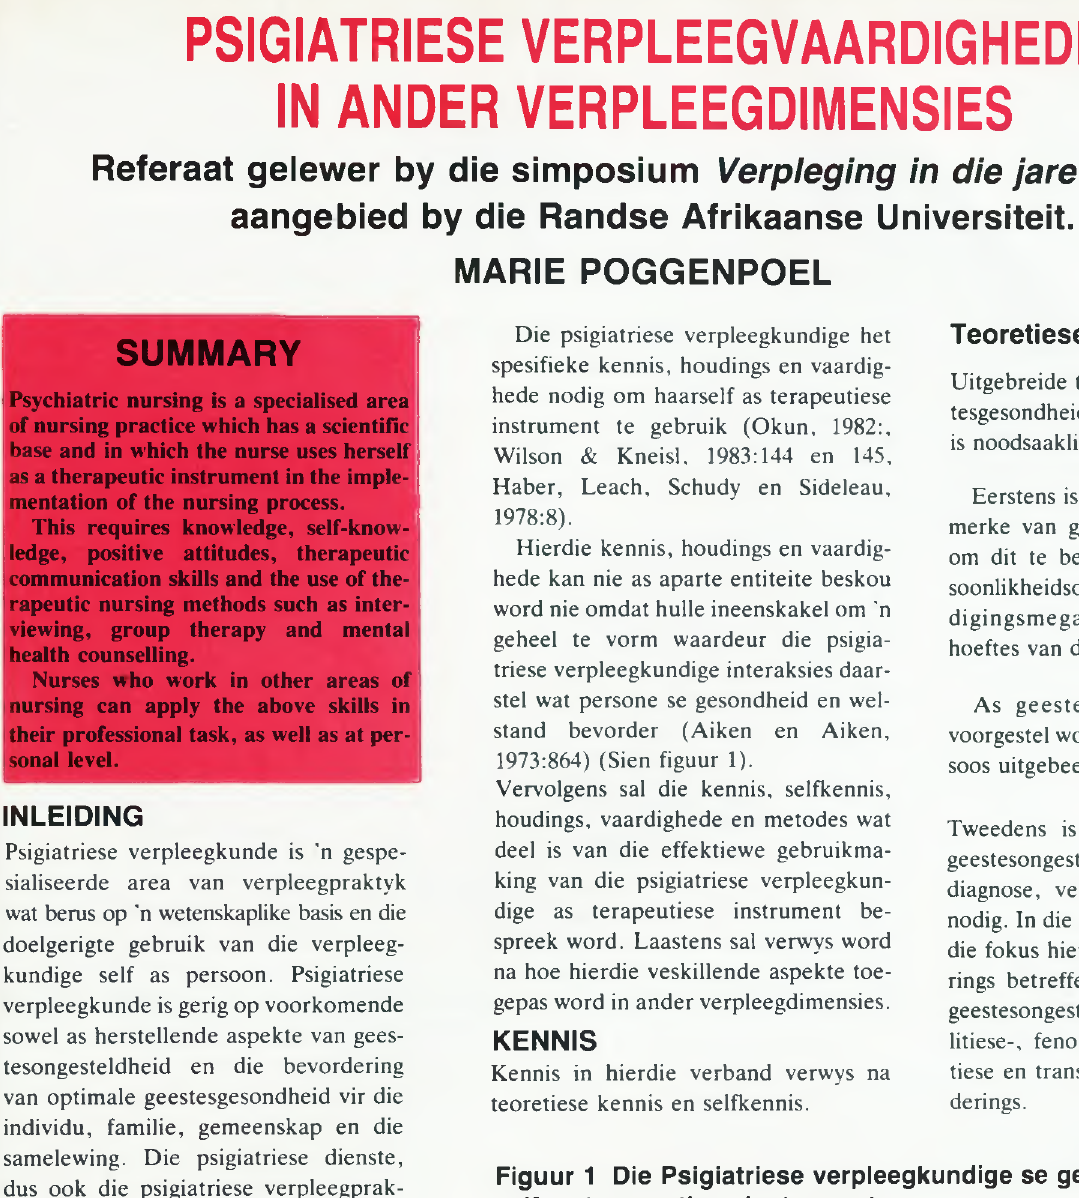
Figuur 1 Die Psigiatriese verpleegkundige se gebruikmaking van self as terapeutiese instrument